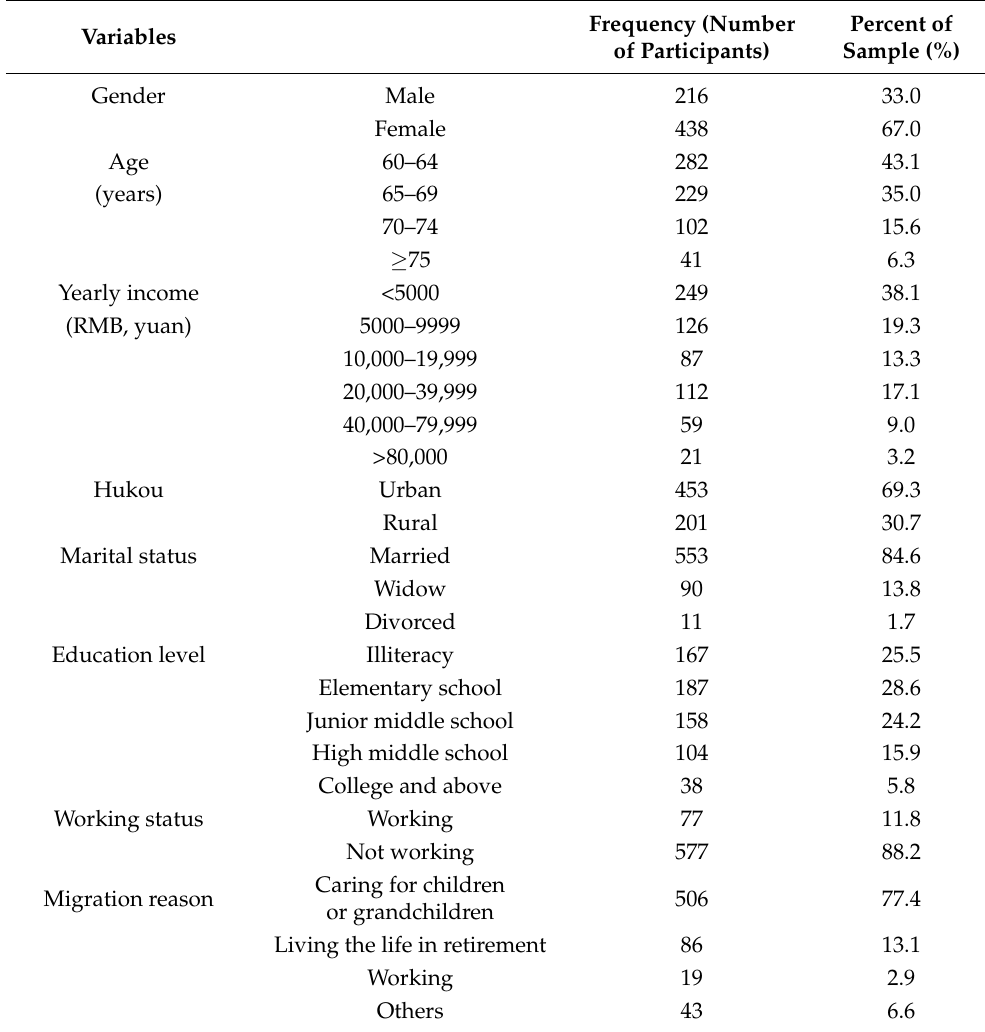
Table 1. Participant Sociodemographic